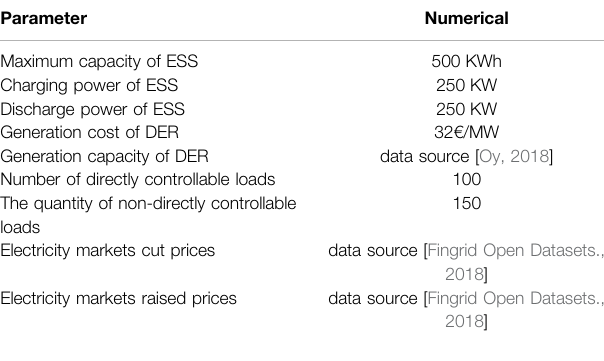
TABLE 2 | The simulation